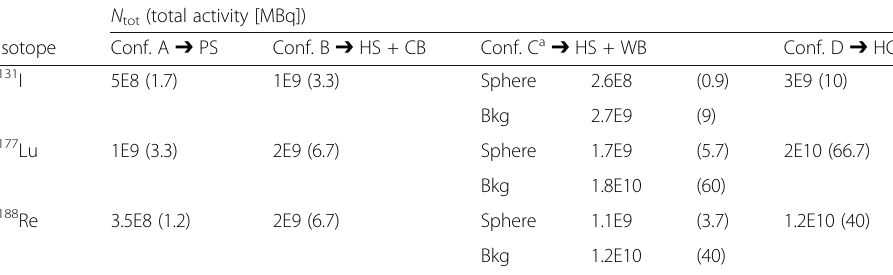
Table 4 Total number of decays used in the simulation experiments. Additionally, for each radioisotope, activities (in MBq) corresponding to these simulations, assuming 5-min acquisition times, are provided (in brackets)